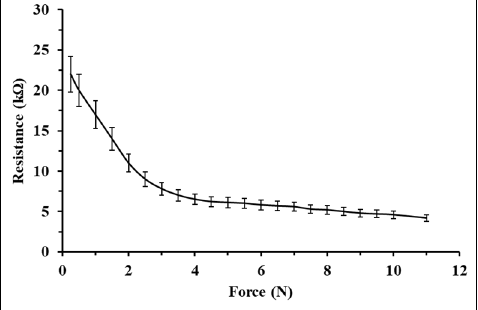
Figure 4. Resistance vs. force response for the sensors.